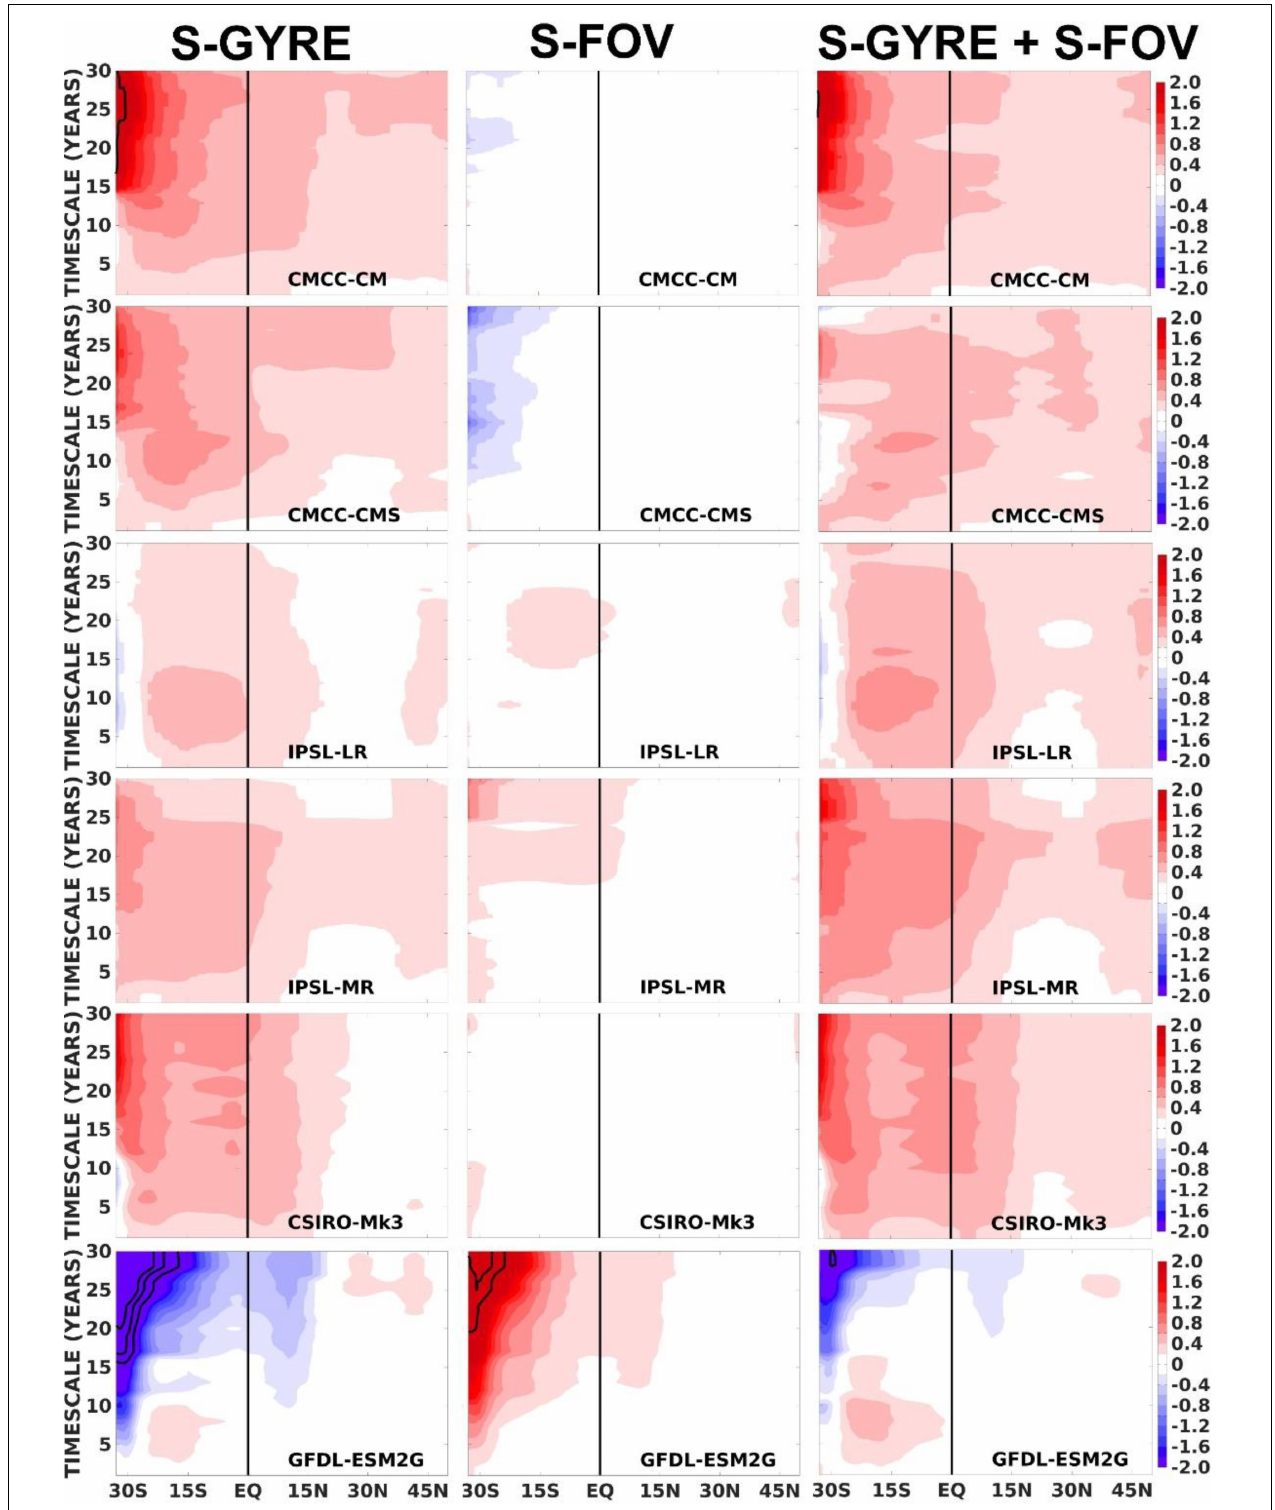
FIGURE 7 | Normalised covariances of the southern F gyre , F ov , and total transports with FWC changes, as in Eq. 8, considering a fixed southern boundary at 34 ◦ S and a moving northern boundary from 33 ◦ S to 50 ◦ N. The spatially varying normalised covariances are evaluated from interannual to multidecadal timescales. The black contours correspond to either negative or positive normalised covariance values of >